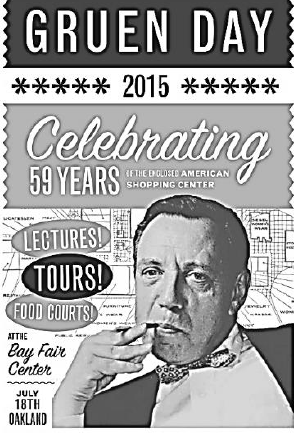
Figure 8. Gruen Day 2015 at the Bay Fair Shopping Mall in San Leandro,